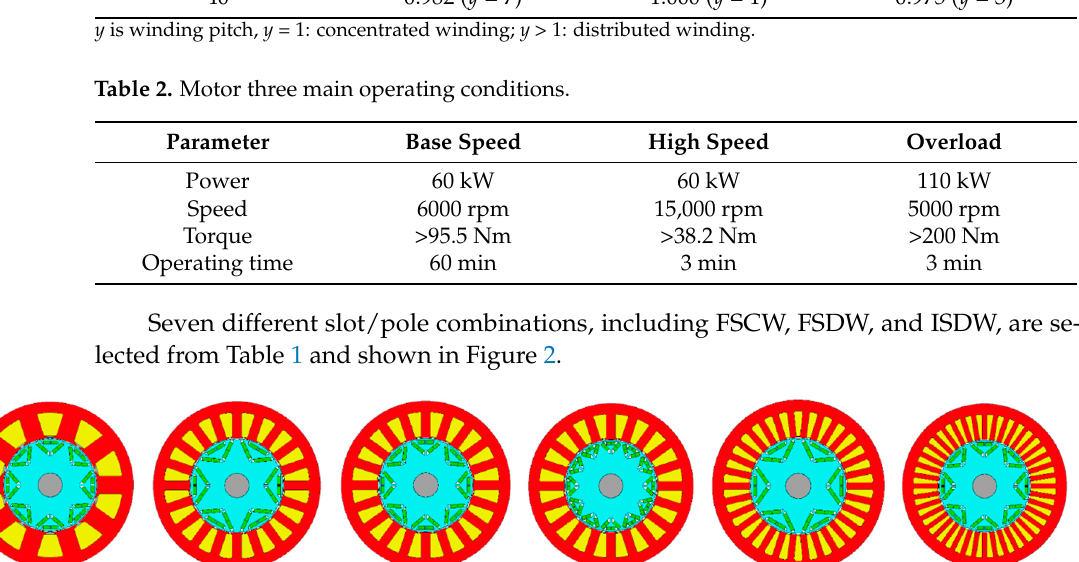
Table 2. Motor three main operating conditions. Figure 2. Selected Seven Different Slot/Pole Combinations: ( a ) 10s6p. ( b ) 10s8p. ( c ) 20s6p. ( d ) 20s8p. ( e ) 20s12p. ( f ) 30s6p. ( g ) 40s8p.